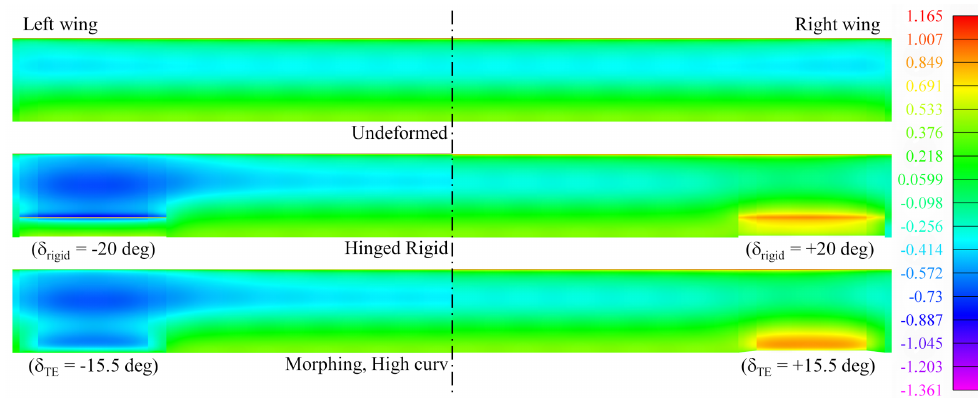
Figure 12. Comparison between the pressure coefficient distribution acting on the lower surface of the wing in three different configurations ( AoA = 1 deg): clean wing (undeformed), hinged aileron rotated of ± 20 deg and optimal morphing aileron with ± 15.5 deg of equivalent rotation.